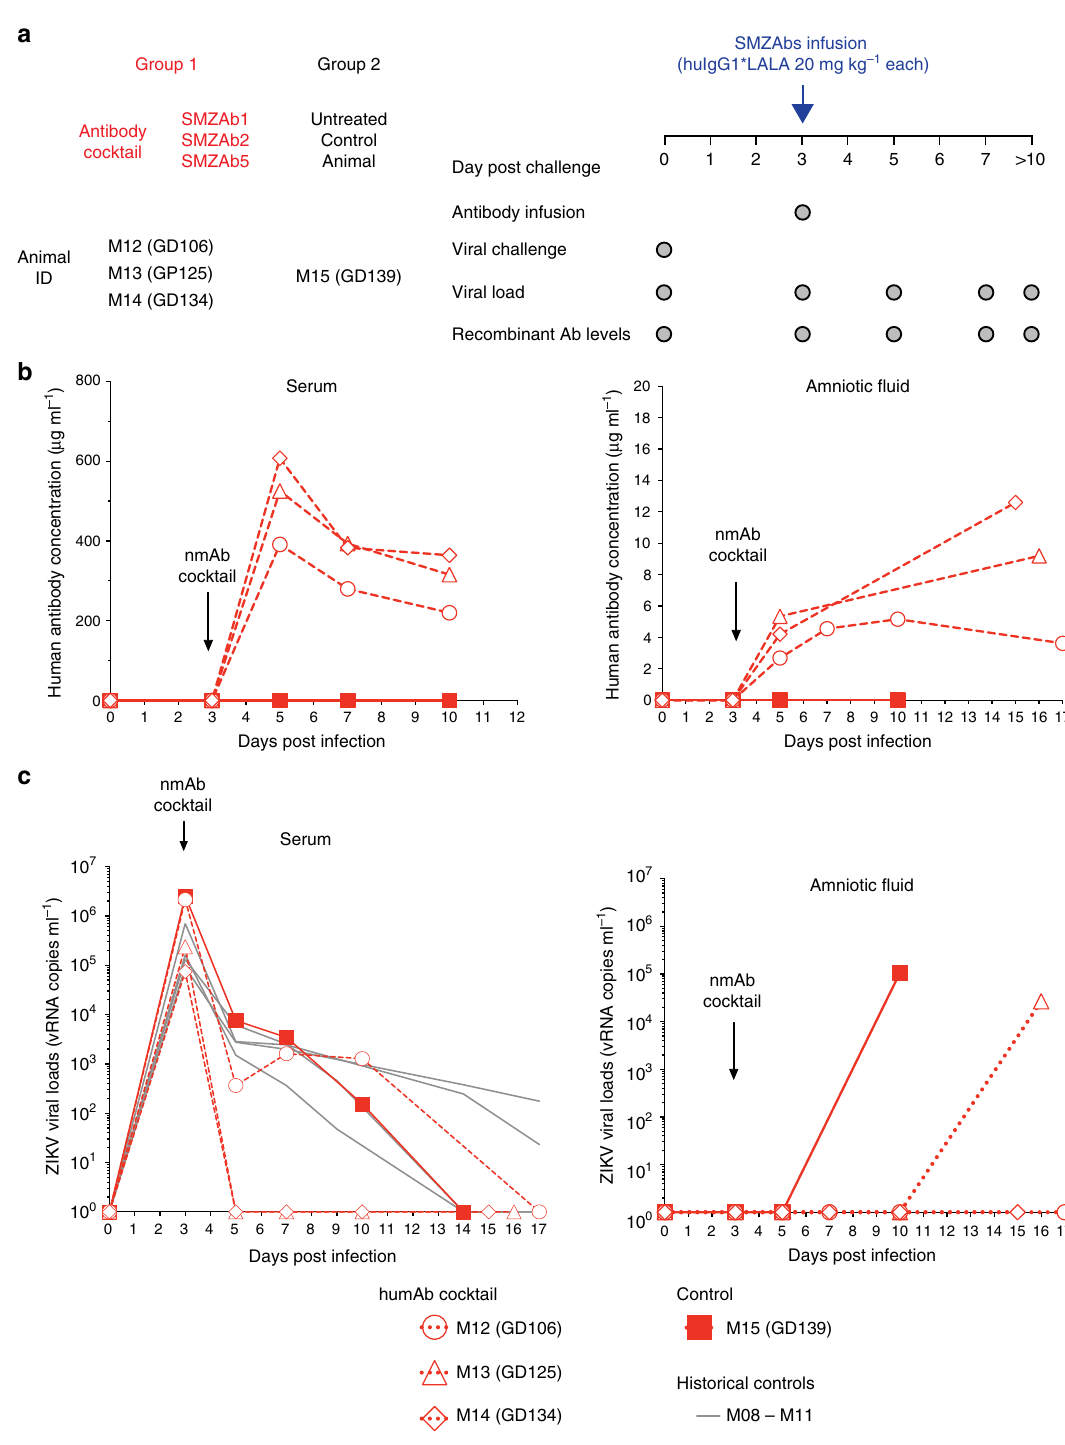
Fig. 3 Therapeutic administration of the SMZAb cocktail to ZIKV-infected pregnant Indian-origin rhesus macaques blocks maternal viremia but does not prevent transmission of virus to fetus. a Treatment study design. Four pregnant rhesus macaques were challenged with 10,000 PFU of ZIKV Rio U-1/2016. On day 3 post challenge, we administered a cocktail containing the three nmAbs, SMZAbs 1, 2, and 5 at a dose of 20 mg kg − 1 each to three rhesus macaques (Group 1). An untreated animal was used as a control (Group 2). Four macaques infected in the third semester of pregnancy (M8 – M11) were used as historical controls. b Serum and AF were collected at the indicated time points for viral load and IgG measurements. c Serum viral loads for SMZAb-treated (open symbols) and control (solid square) escape mutations in the ZIKV envelope coding region. Thus, replication of the viral swarm of the wild-type virus in maternal blood and the AF can occur despite treatment of pregnant animals with a potent ZIKV nmAb cocktail.